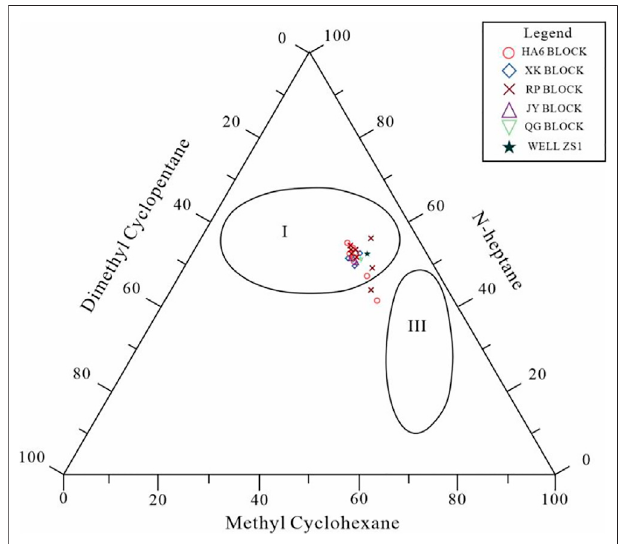
FIGURE5| Triangular plotofC 7 lighthydrocarbonfamily compositionof Halahatang Ordovician crude